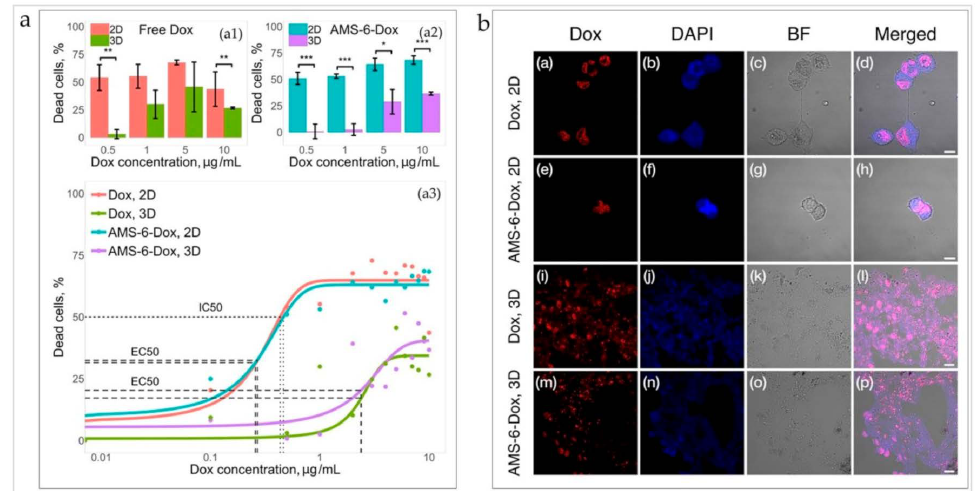
Figure 8. ( a ) Cytotoxicity of free and nanoformulated Dox in 2D cultures of MDA-MB-231 cells and 3D TECs. The top graphs: The effect of free Dox (on the left) and the effect of AMS-6-Dox (right graph). Error bars indicate CI 95% ; statistically significant difference at * p < 0.05, ** p < 0.01, *** p < 0.001 by Mann–Whitney U -test. Bottom graph: Dose–response curves of free Dox and AMS-6-Dox in 2D and 3D in vitro cultures. Solid lines represent the lines of best fit given by Equation (3) (see Tables A6 and A7 in Appendix A.3.5.2 for fit parameters). Note that in the 3D culture, the IC 50 could not be calculated within the studied concentration range (up to 10 µ g/mL). ( b ) Confocal microscopy images of MDA-MB-231 cells incubated for 24 h with ( the upper row ) Dox in 2D; ( the second row ) AMS-6-Dox in 2D; ( the third row ) Dox in 3D; and ( the fourth row ) AMS-6-Dox in 3D TECs. Intrinsic Dox fluorescence was detected in the red channel (Dox), while DAPI fluorescence (blue channel, DAPI) was used for contrasting of cell nuclei. Control bright field (BF) images were acquired to visualize the tissue structures, and merged images highlight the colocalization of Dox and DAPI signals. Dox concentration, 10 µ g/mL. Scale bars, 10 µ m (Dox, 2D; AMS-6-Dox, 2D) and 20 µ m (Dox, 3D; AMS-6-Dox, 3D). The experiments were repeated twice, with at least triplicates for each condition. The illumination conditions were kept constant for every imaging